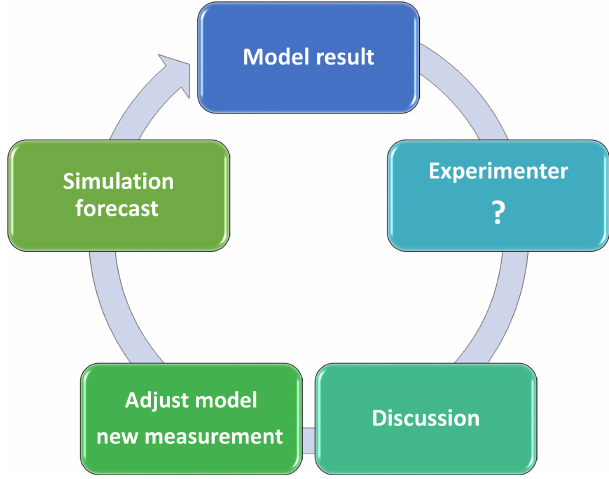
Figure 4. Schema of interactive communication between model- ers and experimenters through the prediction–question–discussion– adjustment–prediction cycle to improve ecological forecasting. The schema is inspired by an episode of experimenter–modeler com- munication stimulated by the EcoPAD-SPRUCE platform. The ini- tial methane model constrained by static-chamber methane mea- surements was used to predict the relative contributions of three methane emission pathways (i.e., ebullition, plant-mediated trans- portation (PMT), and diffusion) to the overall methane fluxes un- der different warming treatments ( + 0, + 2 . 25, + 4 . 5, + 6 . 75, and + 9 ◦ C). The initial results indicated a dominant contribution from ebullition, especially under + 9 ◦ C, which was doubted by experi- menters. The discrepancy stimulated communication between mod- elers and experimenters, with detailed information listed in Table 1. After extensive discussion, the model structure was adjusted and field observations were reevaluated. A second round of forecasting yielded more reliable